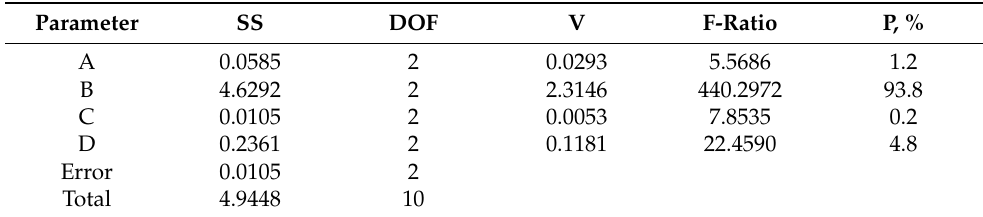
Table 5. Analysis of variance for Cr 3 C